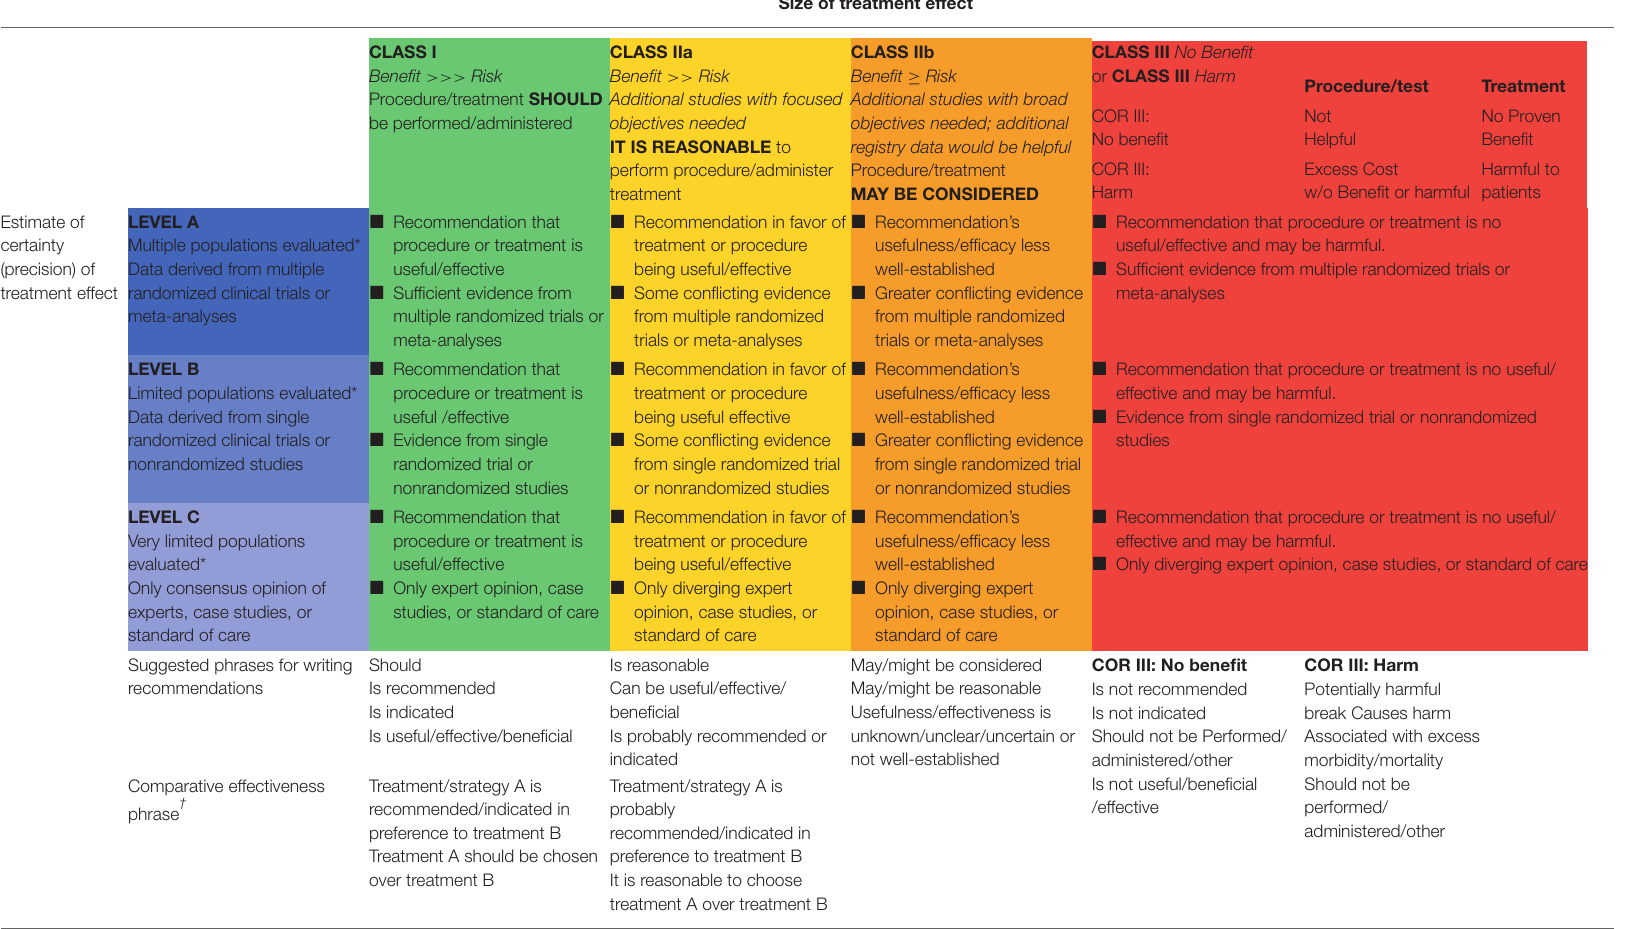
TABLE 1 | Applying classification of recommendations and level of